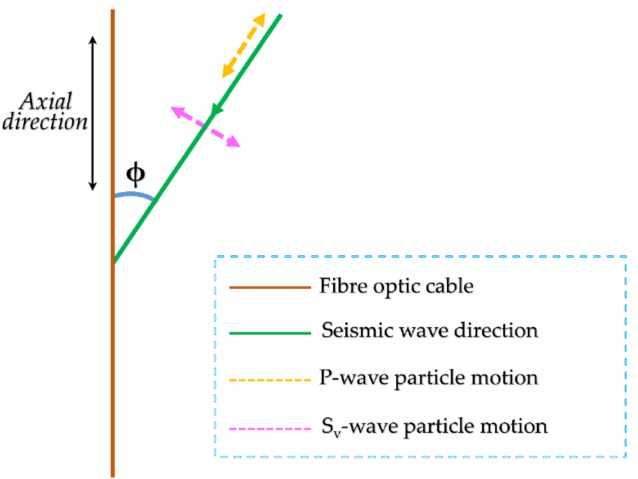
Figure 12. Directional sensitivity of DAS to body waves. DAS is most sensitive to the component of particle motion that is in the axial